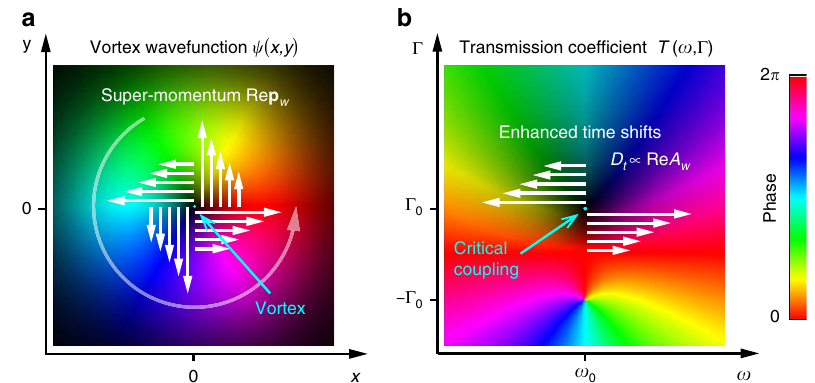
Figure 2 | Analogy between anomalous weak momentum in a vortex wavefunction and time delays of a wave packet in near-zero scattering. ( a ) Weak measurements of the momentum in a vortex wave field, c ( r ), described by equation (8), result in the anomalously large weak values (super-momentum) p w near the vortex core 18 . Here, the localized vortex wavefunction c ¼ ( x þ iy ) exp ( (cid:3) x 2 (cid:3) y 2 ) is shown. ( b ) Anomalously large time delays D , given by equations (5)–(7), which appear in the vicinity of the zero of the transmission coefficient T ( o , G ) (critical coupling), have the weak-value form (10) similar to equation (8). In both panels, colours indicate the phases of the complex functions, whereas brightness corresponds to their absolute